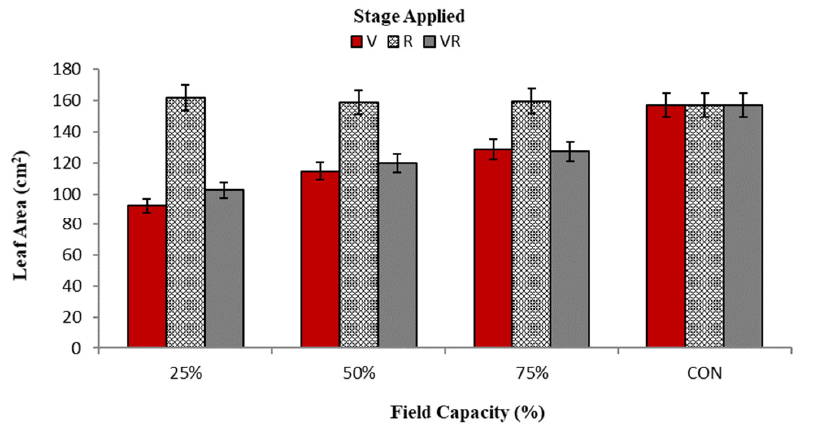
Figure 6. Effect of water deficit and treatment stage on leaf area of okra at 4 weeks V (vegetative), R (reproductive), and VR (vegetative and reproductive) represent the stage at which the deficit was applied. Data in the interaction analysed with Least Squares Means, and means separated with LSD.